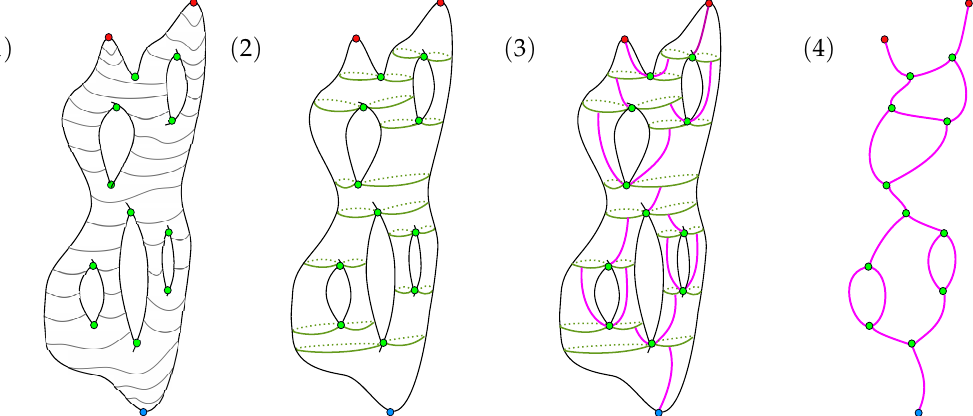
Figure 6. Summary of the sequential algorithm. (1) The input of the algorithm is a manifold M with a scalar function f . (2) Computing the critical sets. (3) For each saddle point or minimum, we compute the ascending paths (4) creating the edges of the Reeb graph by the information encoded in the start vertex of the ascending vertex and its termination critical